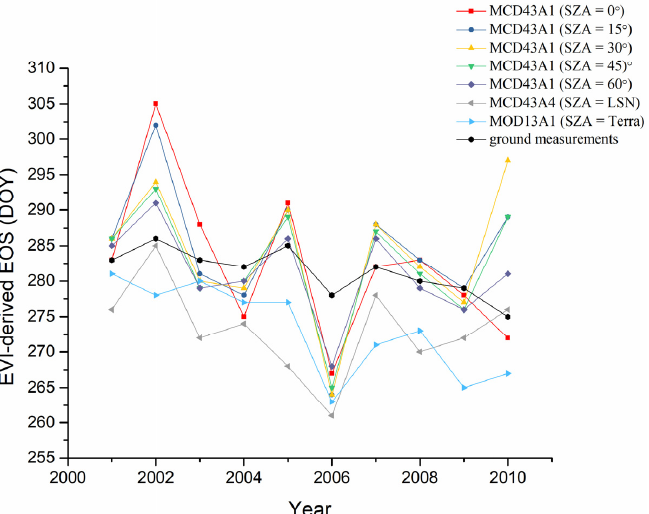
Figure 7. EOS derived from the EVI time series from 2001 to 2010. SZA = 0°, 15°, 30°, 45° and 60° denote the EOSs derived from the MCD43A1 (BRDF) product with a consistent angle configuration; SZA = LSN and SZA = Terra refer to EOSs derived from the MCD43A4 (NBAR) product and the MOD13A1 (VI) product, respectively. Table 5. Difference between the ground-observed and EVI-derived